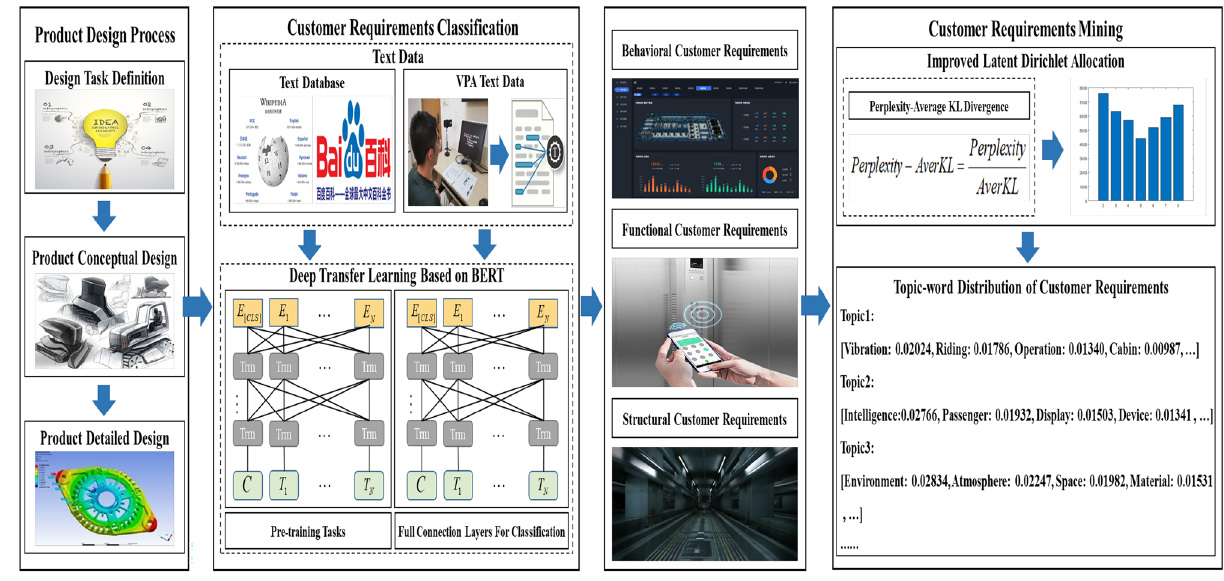
Figure 1. The overall implementation